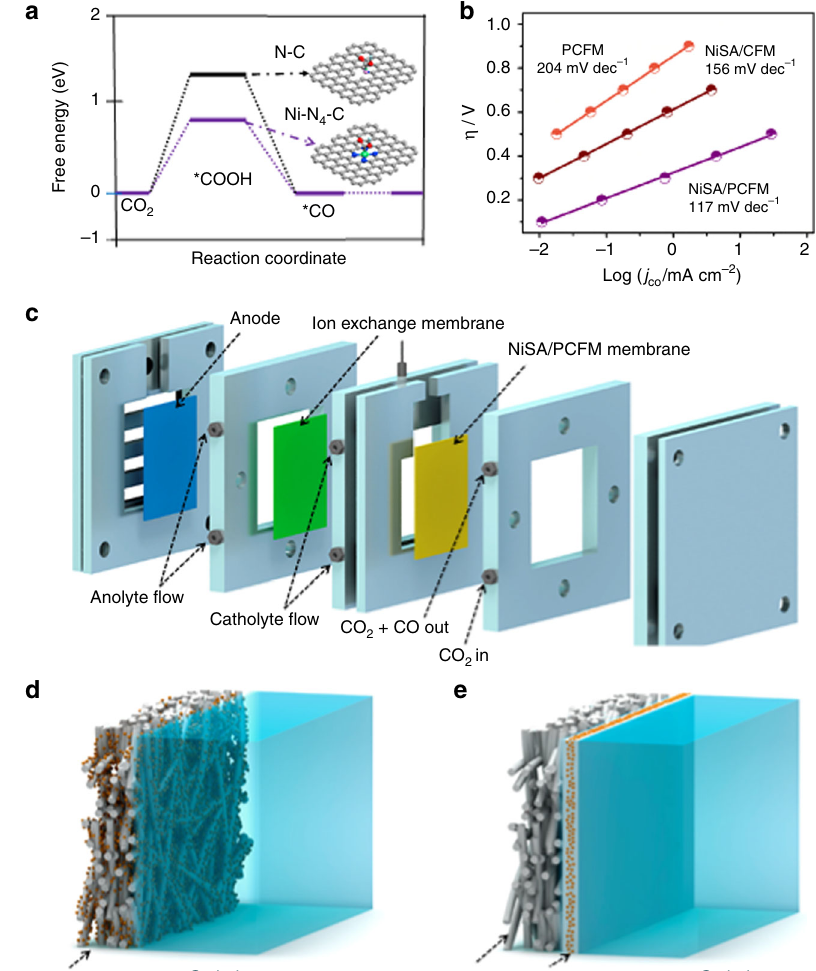
Fig. 5 Proposed mechanism of NiSA/PCFM. a Free energy diagram of CO 2 to adsorbed *COOH intermediate on N-C and Ni-N 4 -C doped graphene structure; b Comparisons of Tafel plots. c Graphic illustration of a GDE device; Schematic for d NiSA/PCFM membrane directly used as GDE and e typical GDE cell with catalyst powder loaded onto a gas-diffusion layer via polymer